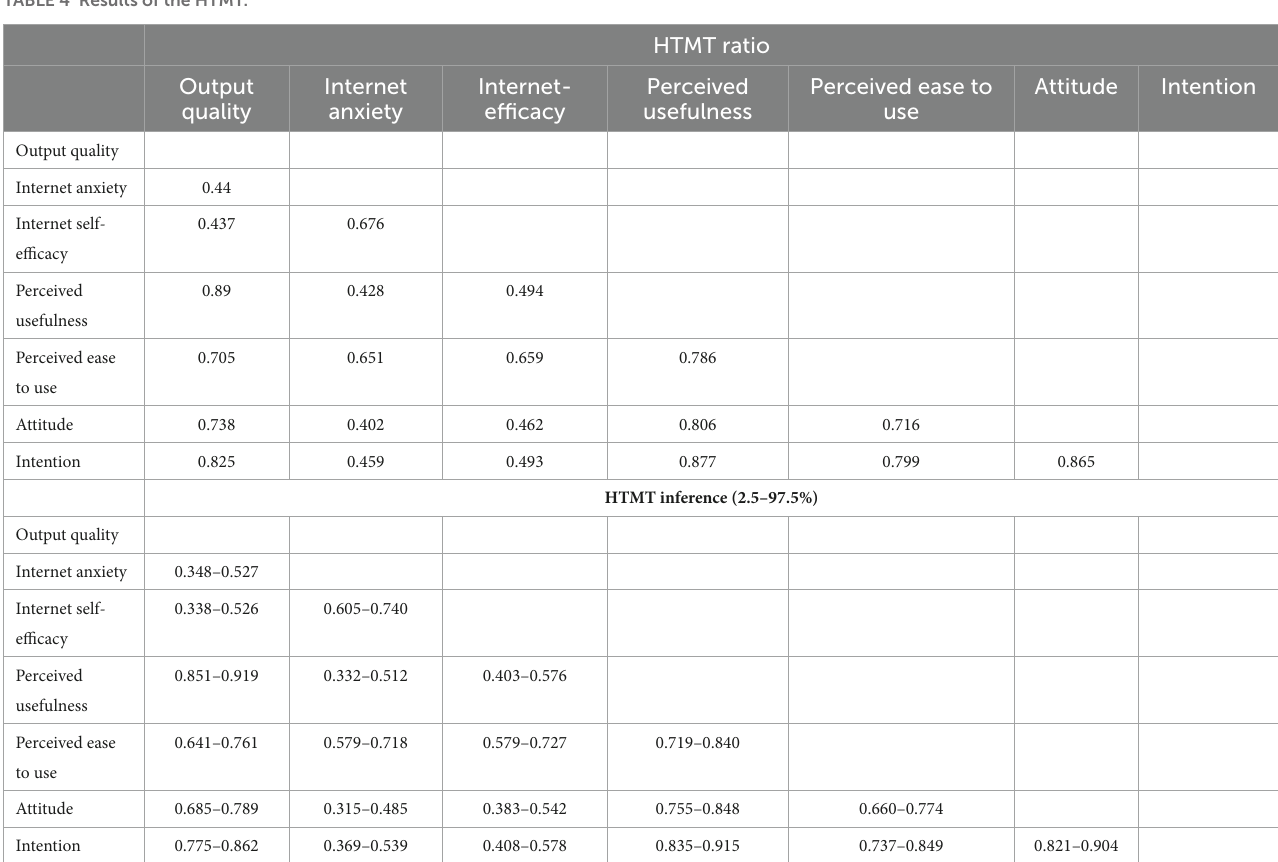
TABLE 4 Results of the